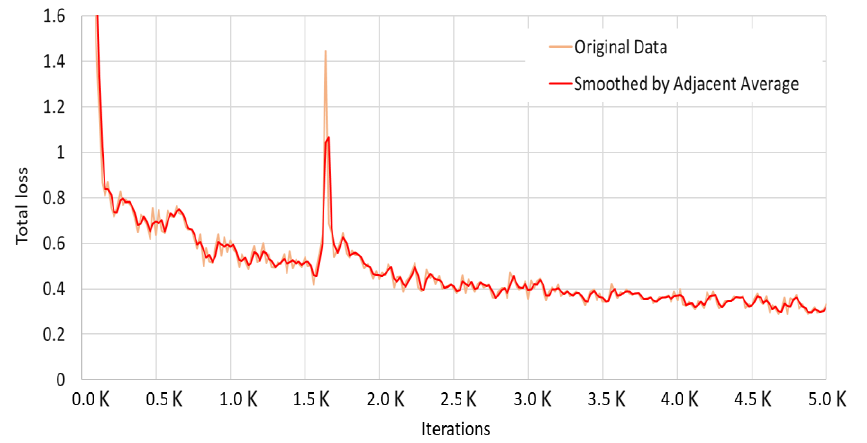
Figure 11. MASK R-CNN Segmentation Loss Curve (source: TensorBoard Image).